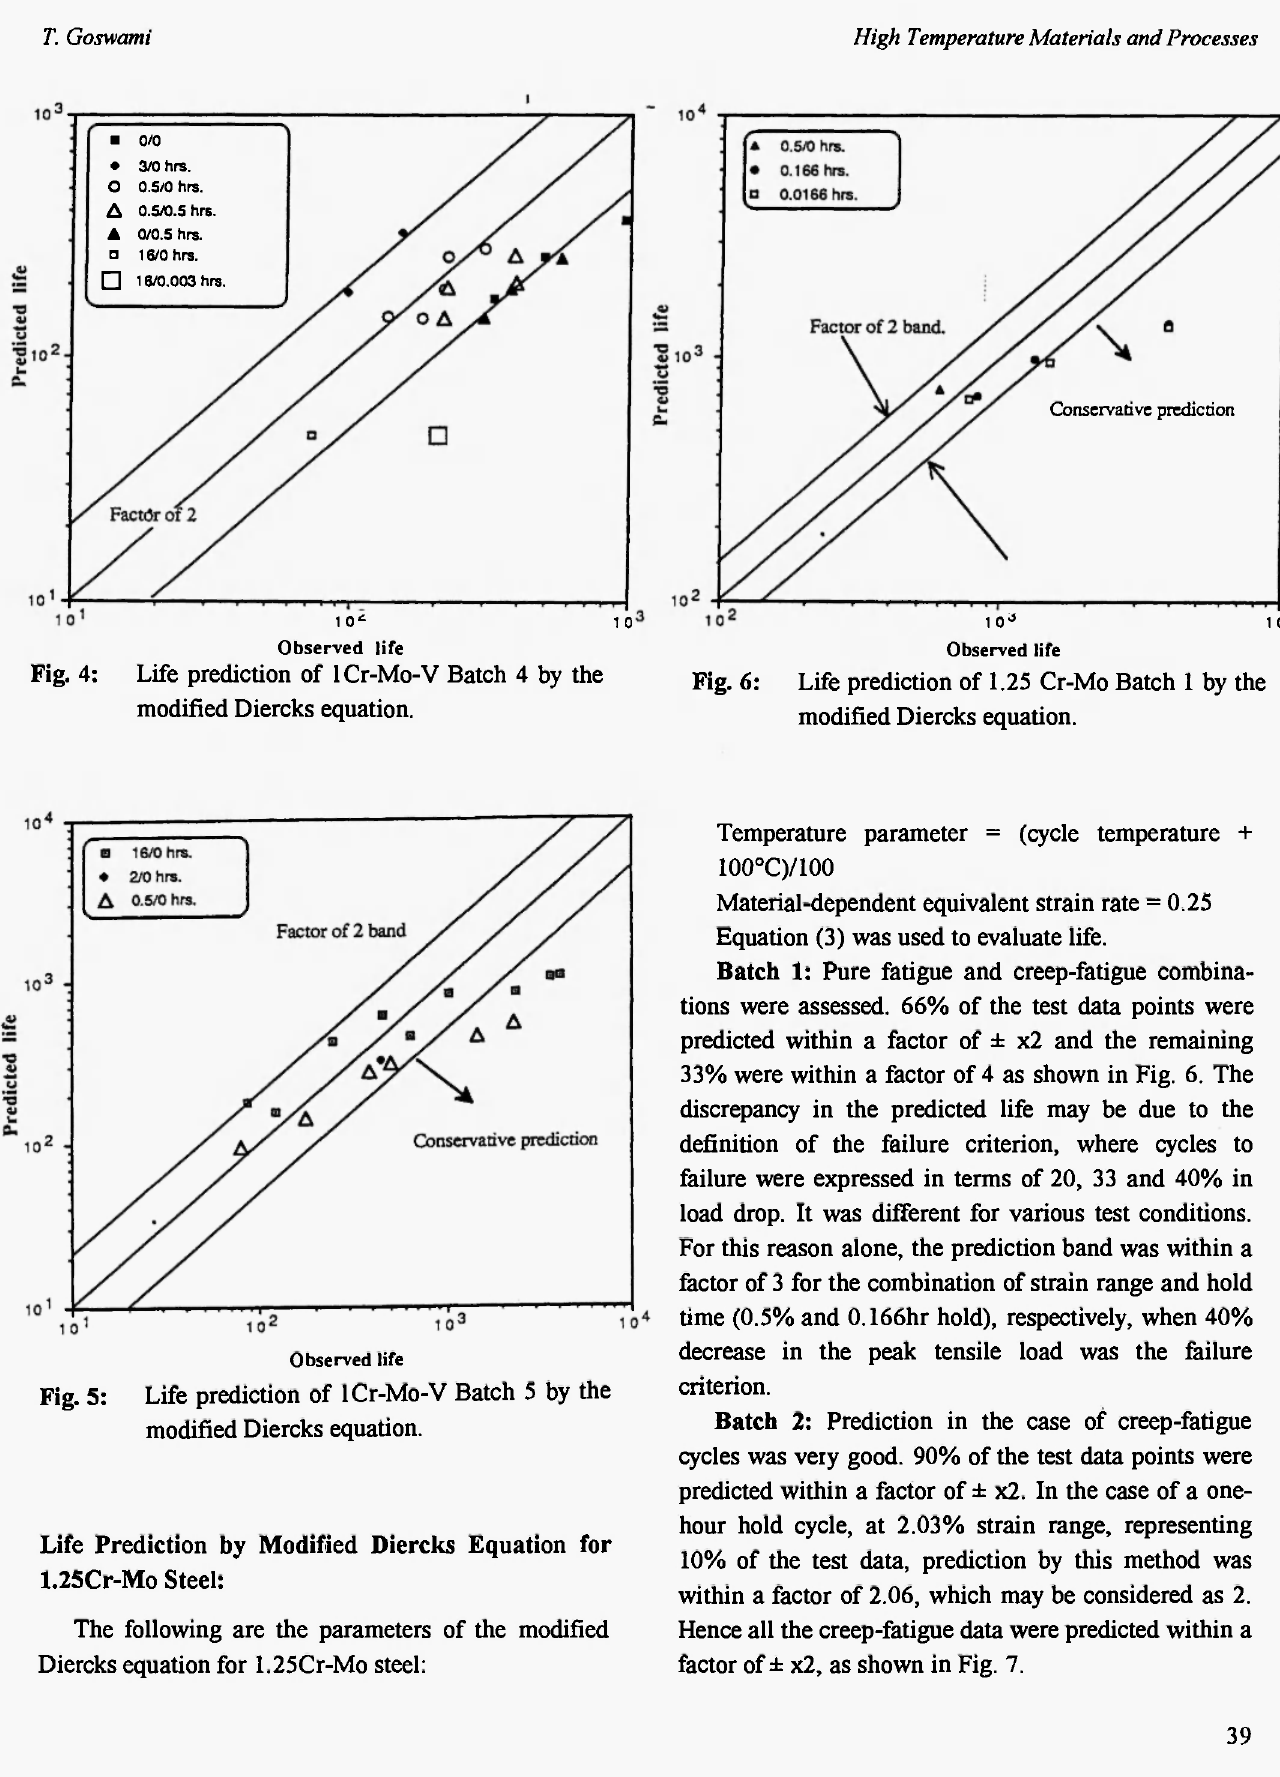
Fig. 5: Life prediction of lCr-Mo-V Batch 5 by the modified Diercks equation.